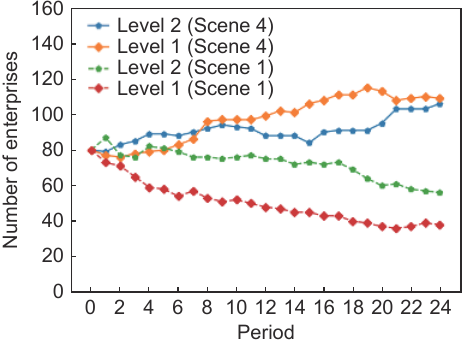
Fig. 10 Scenes 1 and 4: Changes of number of enterprises in Levels 1 and 2.